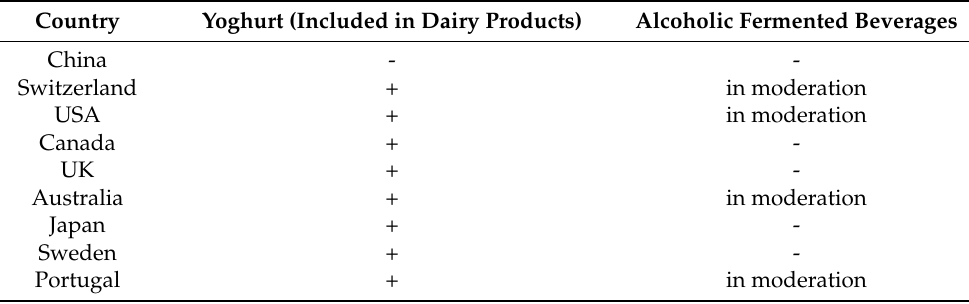
Table 3. Fermented products within food-based dietary guidelines in some